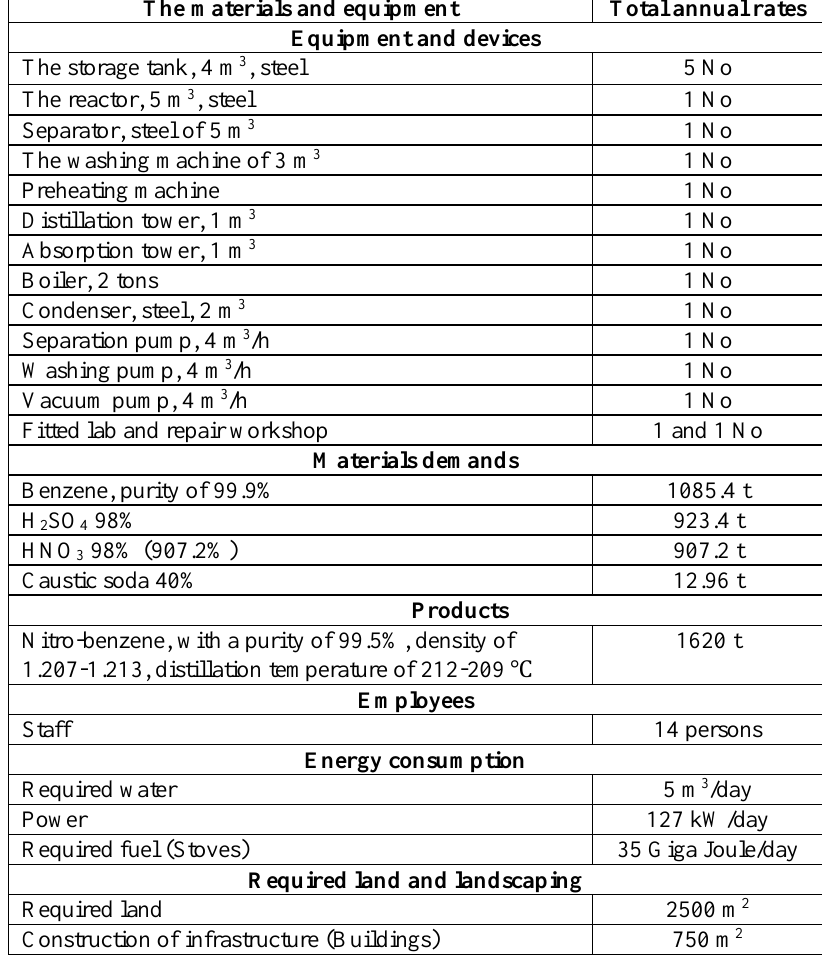
Figure 8: The layout of units of Nitrobenzene generation industries. Source: Author, (2021). Table 7: The annual requirements of industries of Nitro-benzene (nominal capacity of 1620